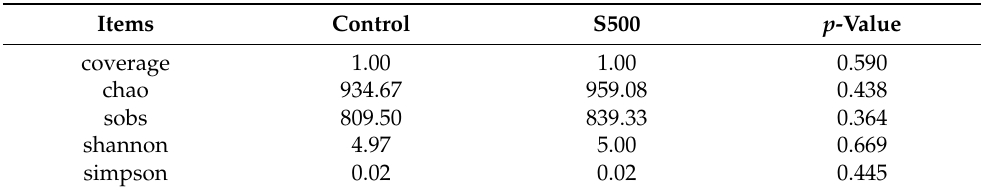
Table 3. The alpha diversity of the 16S rRNA gene libraries from cecal microbiota of laying hens in the control and S500 groups ( n = 6).